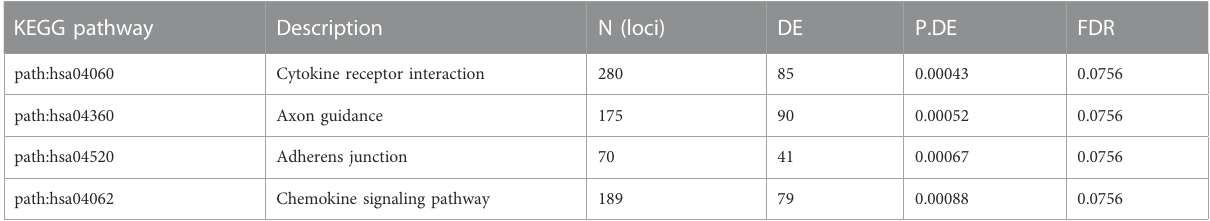
TABLE 7 KEGG pathway analysis of differential methylation with dimethyl fumarate treatment.